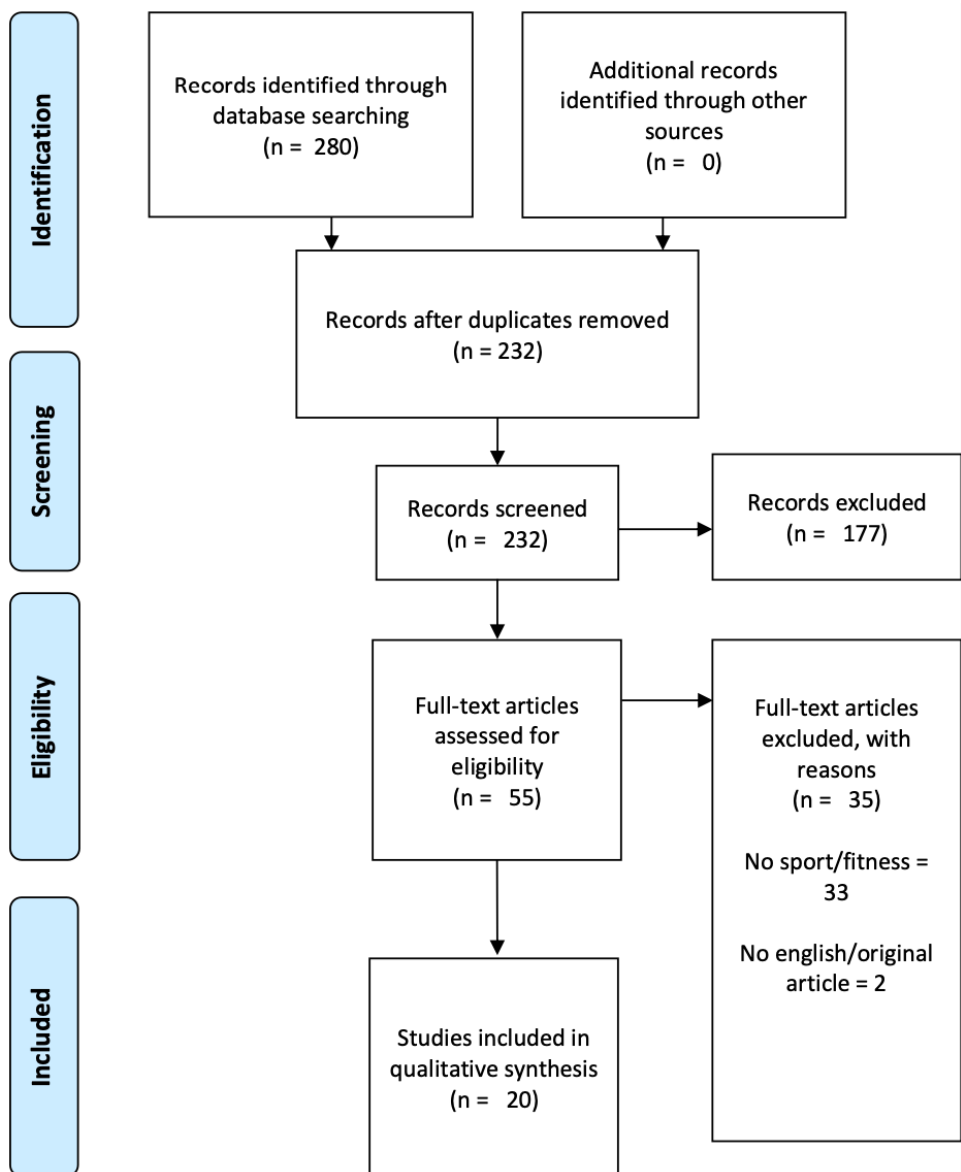
Figure 1. PRISMA Flow